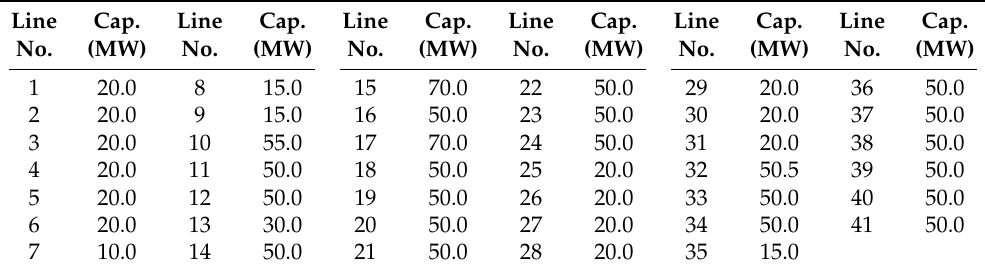
Table 1. Line flow capacities of the IEEE 30-bus model test